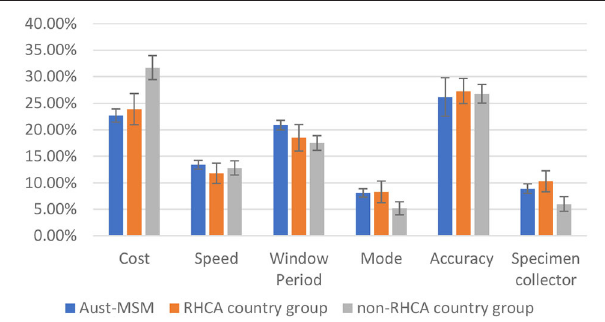
FIGURE 1 | Relative importance of HIV testing attributes among Aust-MSM, RHCA country group, and non-RHCA country